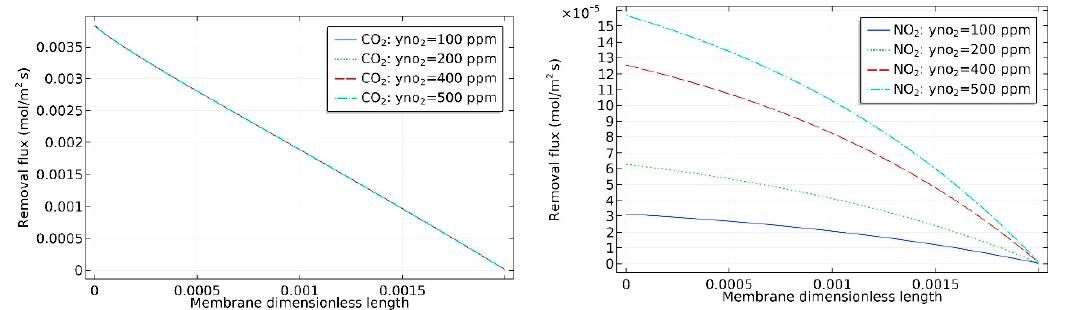
Figure 7. Effect of NO 2 mole fraction in the feed gas stream on the removal molar flux of CO 2 (left) and NO 2 (right) at other fixed parameters (liquid velocity: 0.05 m/s; gas velocity: 2.11 m/s; 0.5 M NaOH; 100 to 500 ppm NO 2 ; 2% CO 2 ; the balance is N 2 ).